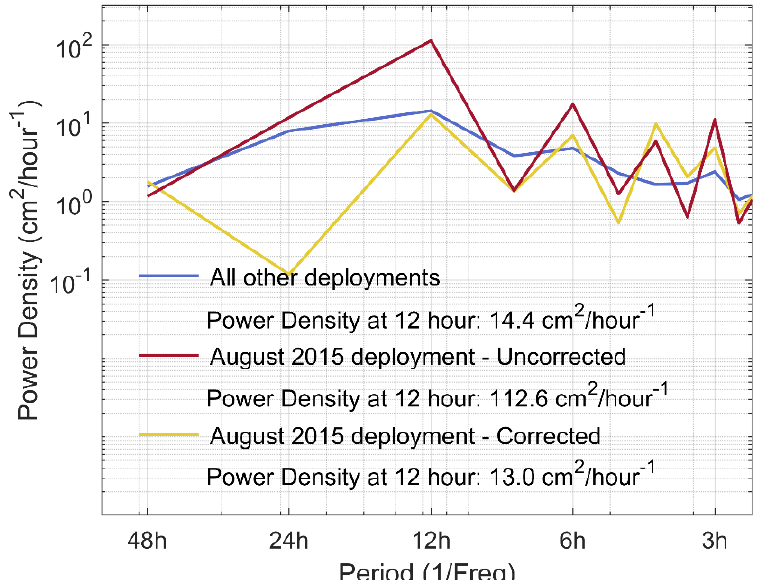
Figure 5. Power spectrums of buoy-mooring SSH residual. Blue line is the median spectrum for residuals from all the other deployments excluding August 2015, all with less apparent quasi-semi-diurnal signals; Red line is the raw August 2015 deployment residuals; Yellow line is following correction using the empirical model. Note the focus of this figure is on the low frequency bands, hence only these bands are shown.